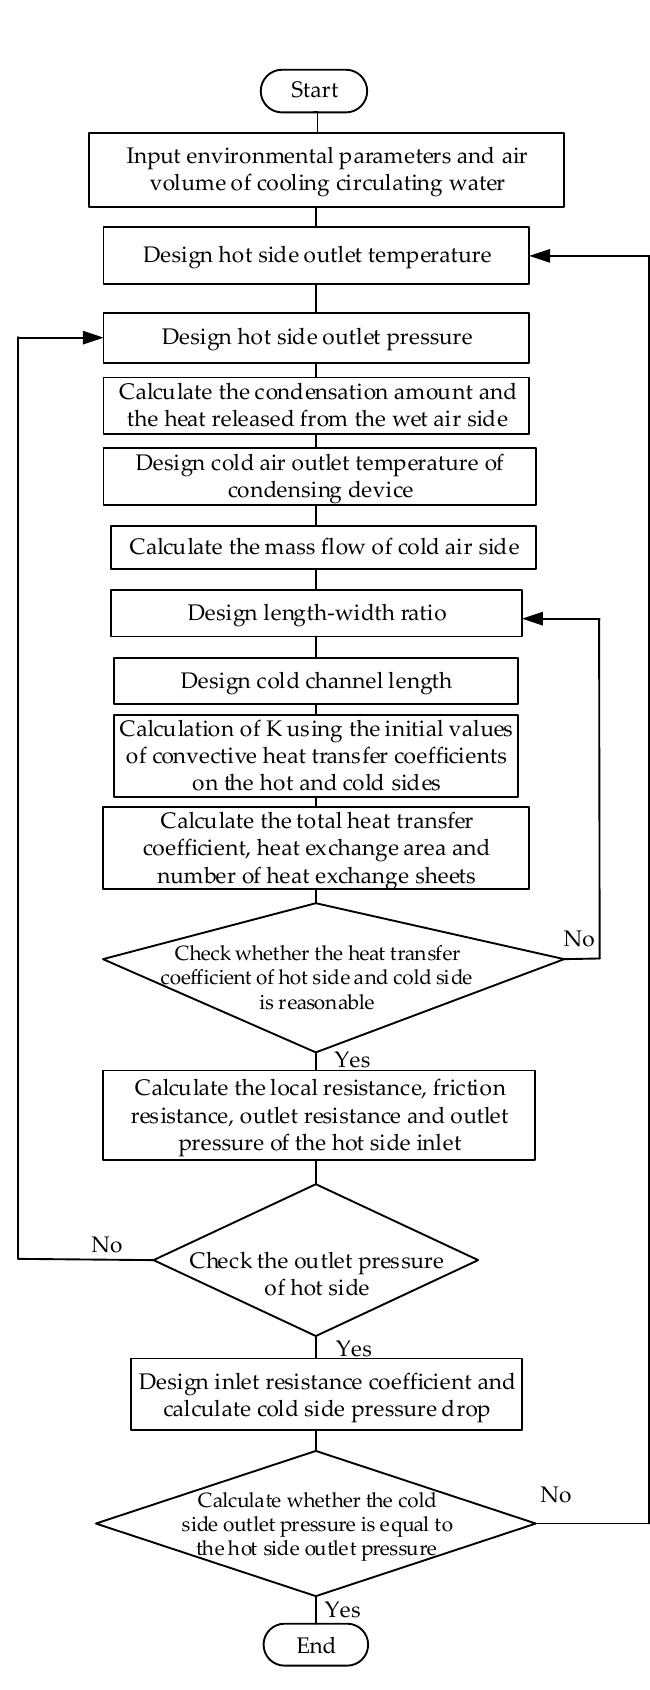
Figure 6. Calculation flow chart of condenser.